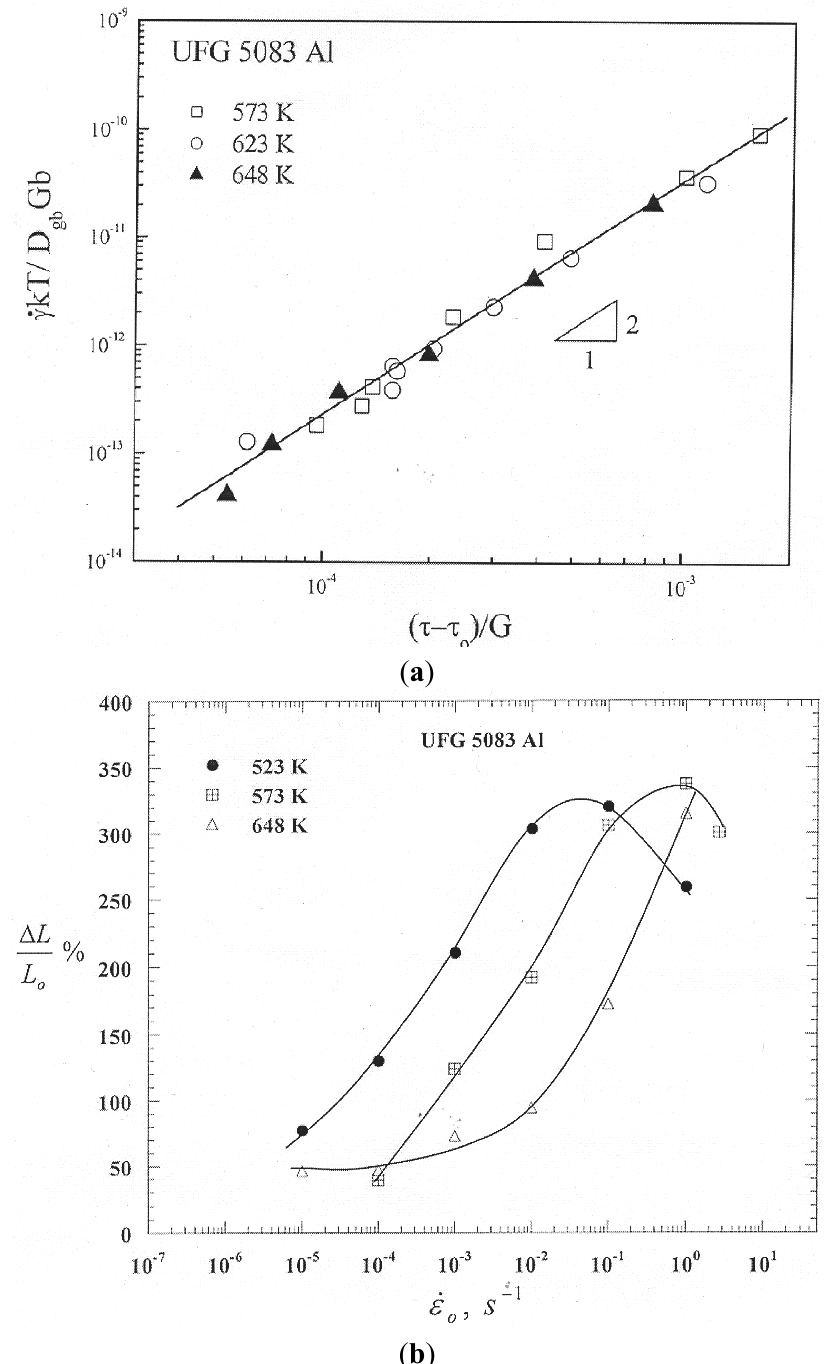
Figure 18. ( a ) Normalized strain rate vs. normalized effective stress; ( b ) Ductility in UFG